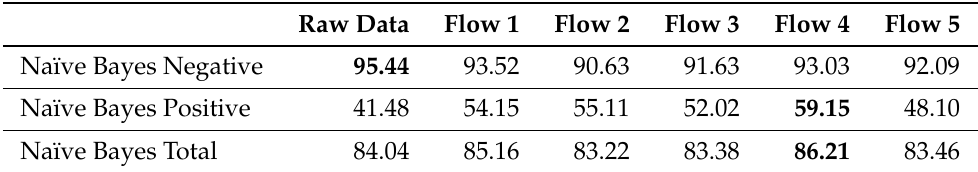
Table 5. Accuracy of the naïve Bayes classifier when testing, separately, with positive and nega- tive tweets.